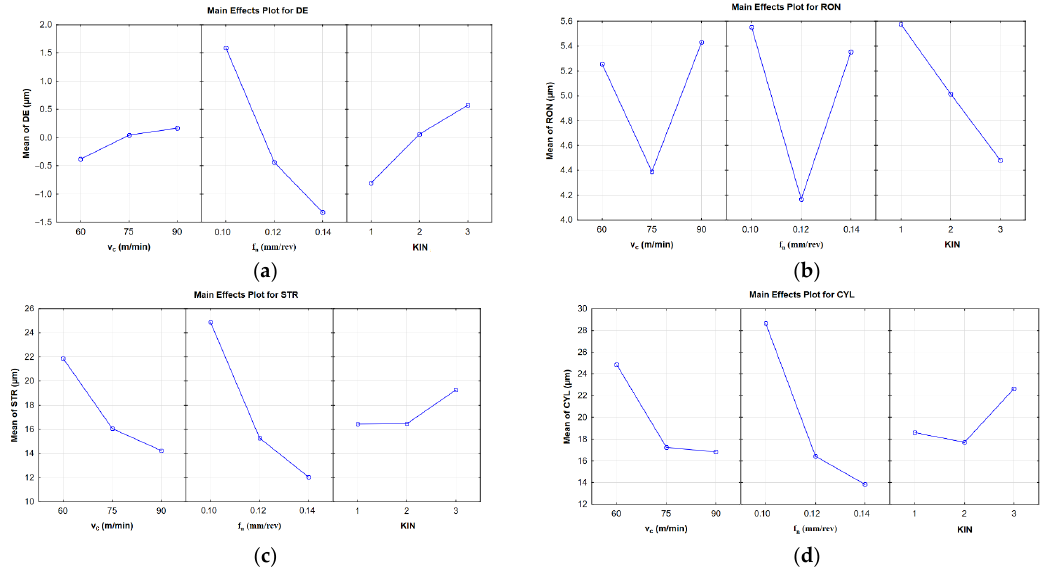
Figure 5. Main effects plots for ( a ) the diameter error; ( b ) the roundness error; ( c ) the straightness error; ( d ) the cylindricity